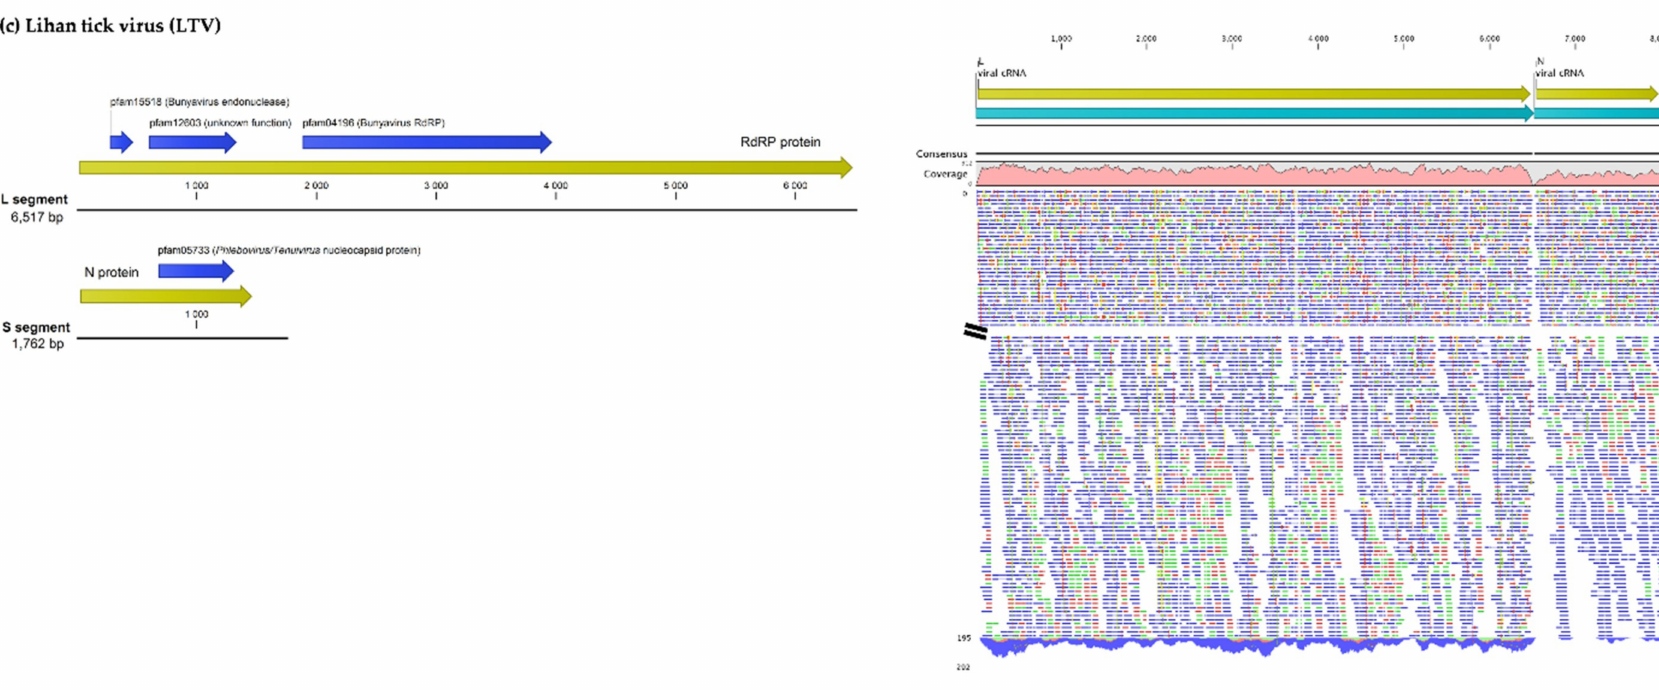
Figure 1. Genomes structure and organization of the two Chuviridae , ( a ) Karukera tick virus ( b ) Wuhan tick virus 2 and the Phenuiviridae ( c ) Lihan Tick Virus detected in Rhipicephalus microplus and Amblyomma variegatum ticks collected in Guadeloupe and Martinique. Coding sequences are highlighted with a yellow arrow and pfam functional domains with a blue arrow. Genome horizontal coverage are indicated in pink. For clarity, read mapping for LTV was performed on concatenated segments (represented by a green